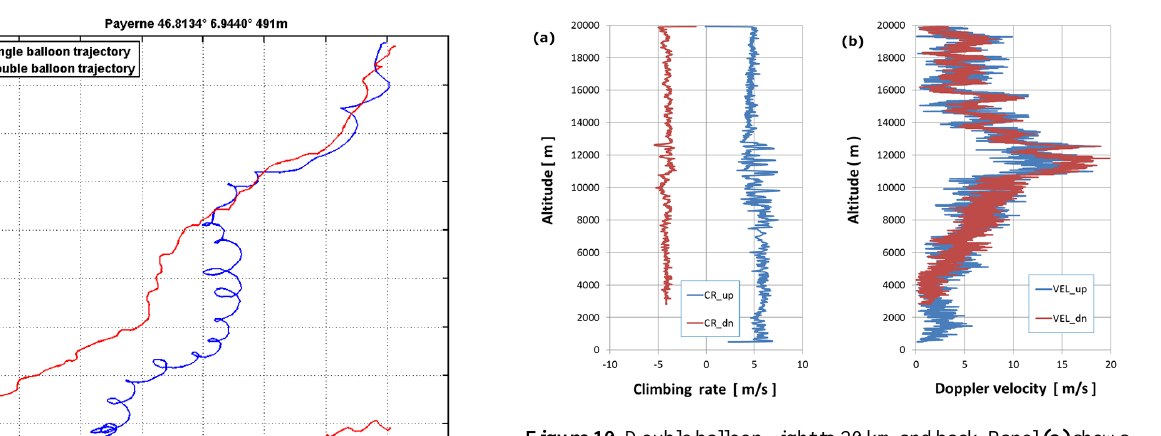
Figure 10. Double balloon flight to 20km and back. Panel (a) shows the ascent and descent rates as functions of altitude. Panel (b) shows the Doppler velocity with considerably less noise during the descent than during the ascent, which demonstrates that for the double bal- looning method, the descent is more quiescent than the